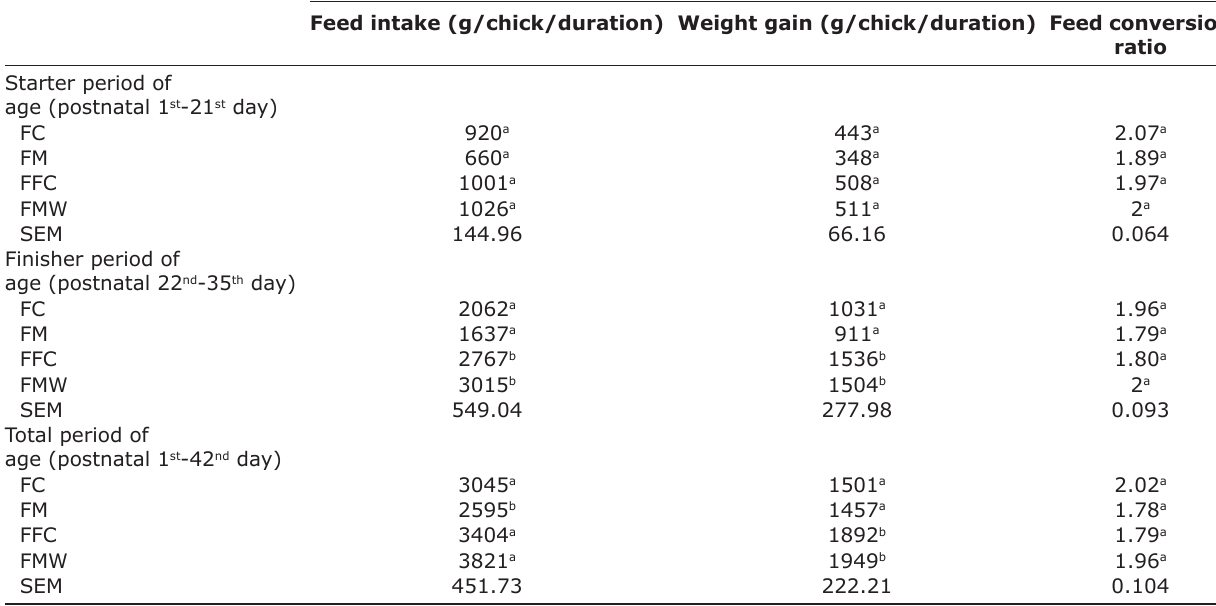
Table-4: Performance mean (±SEM) of Ross 40 broilers at starter, finisher and total periods of age fed with different agroindustrial waste sampled from postnatal 1 st -6 th weeks*. Treatment